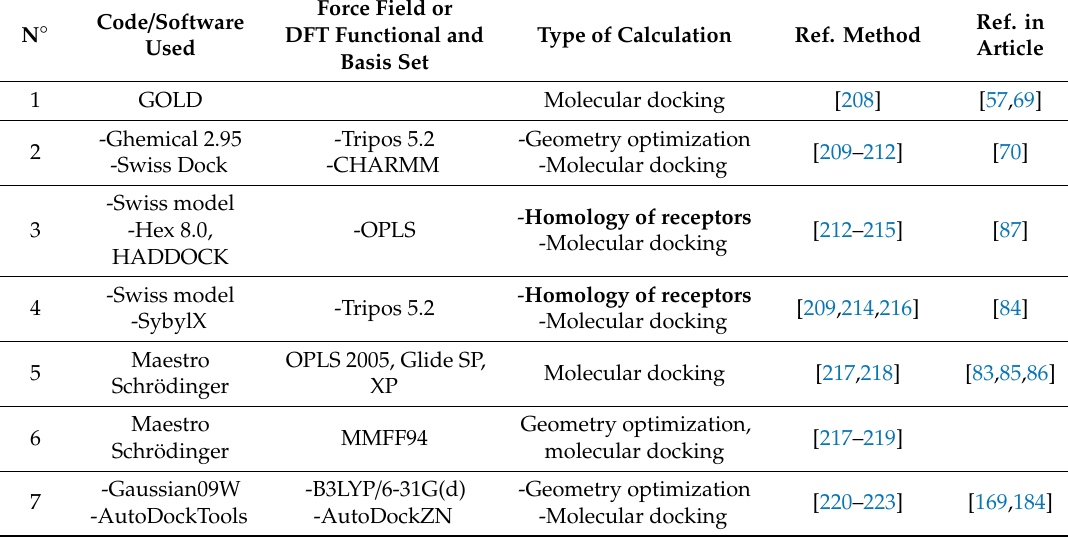
Selected technical computation data in terms of ER and (xeno)estrogens regarding the publications cited in this